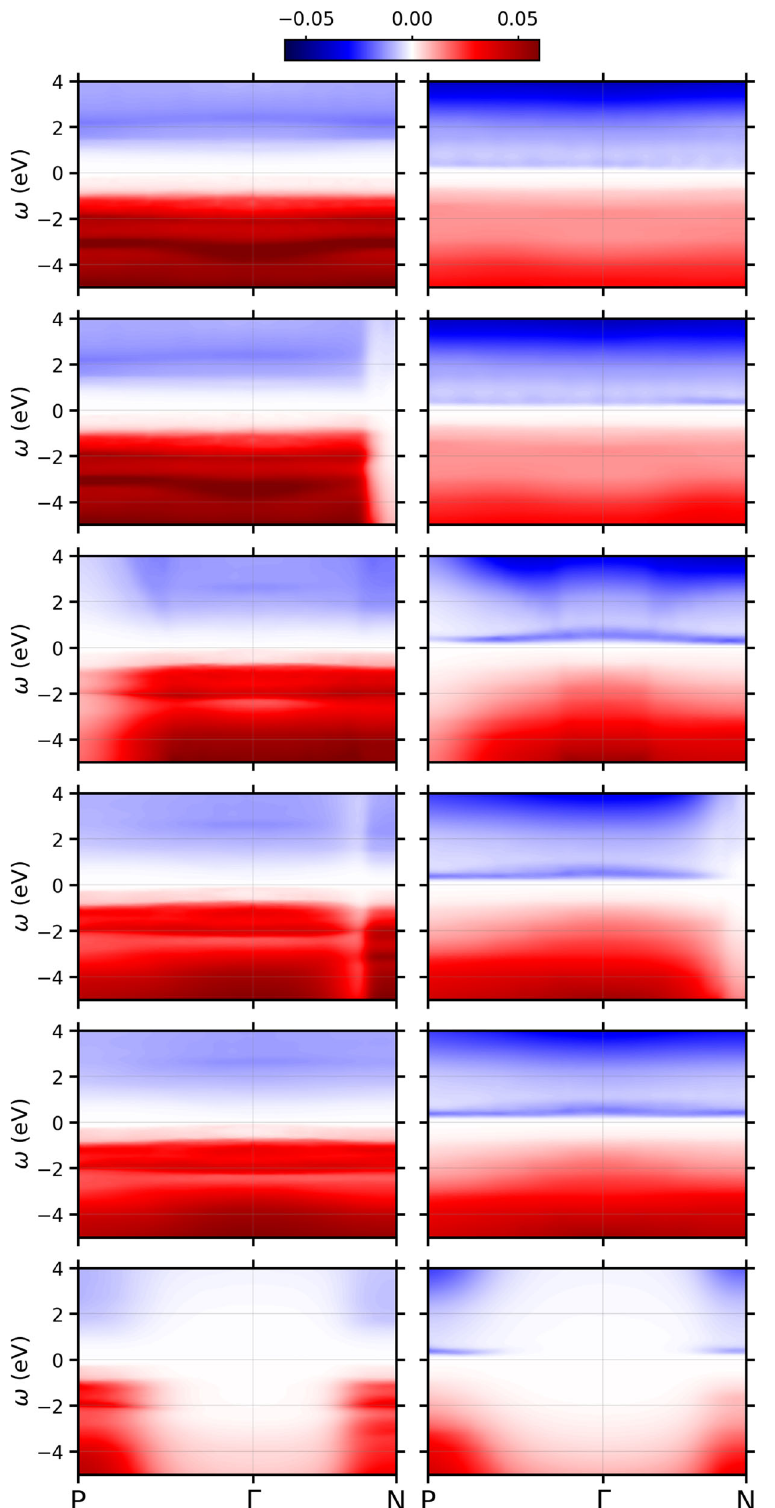
Fig. 6 Momentum and energy dependence of the correlation self-energy in Fe. Im Σ σ spins ( cf . Fig. 1). The bands are ordered with respect to their energy at Γ from bottom to top (same order as in Fig. 10 of ref. 19 ).